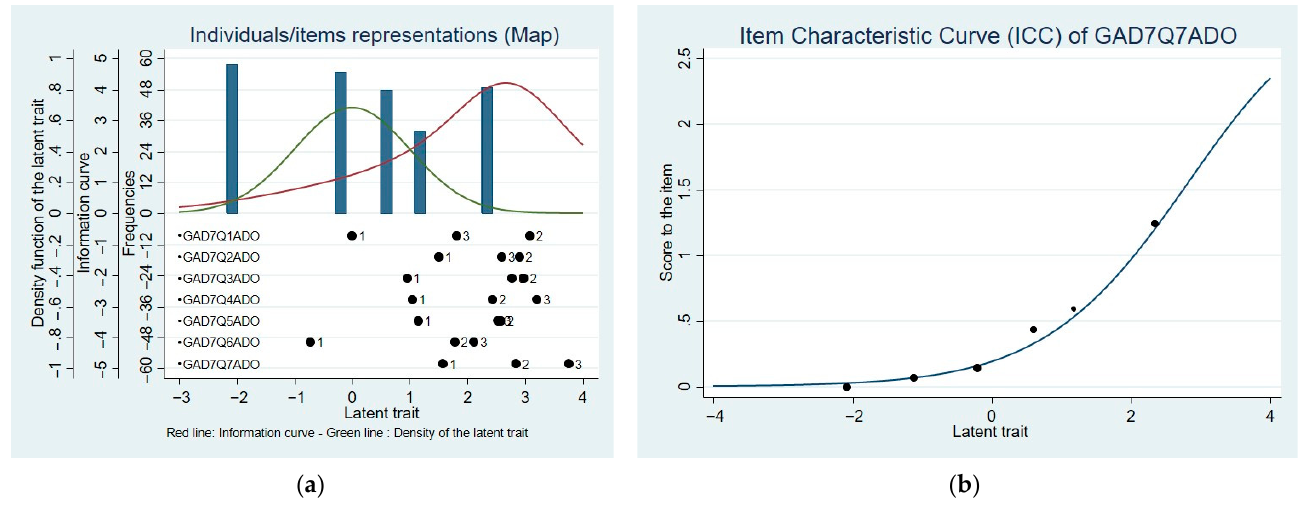
Figure 1. ( a ) Map of individuals/items representations: latent trait (anxiety) in function of density of the latent trait, information curve, and frequencies, with indicated thresholds of response modes for each item (GAD-7). ( b ) Figure 2 Item Characteristic Curve (ICC) of item #7 of GAD-7.